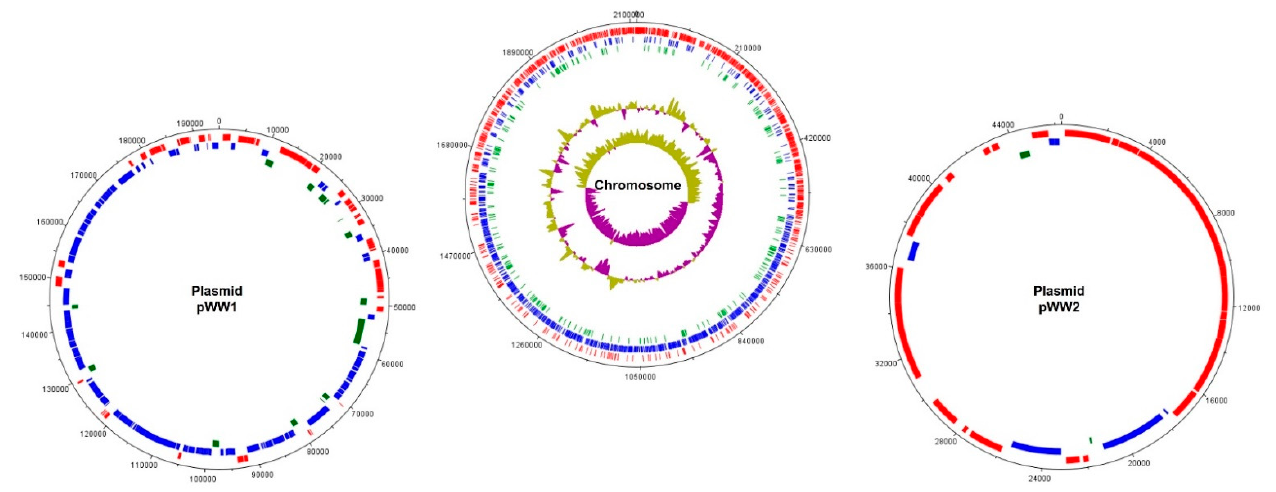
Figure 1. Circular maps of the L. kefiranofaciens ZW3 chromosome and plasmids pWW1 and pWW2 generated by DNAPlotter [14]. Labeling from the outside to the inside of the circle, each ring contains information on the chromosome: CDSs on the forward strand (red); CDSs on the reverse strand (blue); Putative pseudogenes (green); GC content; GC skew.